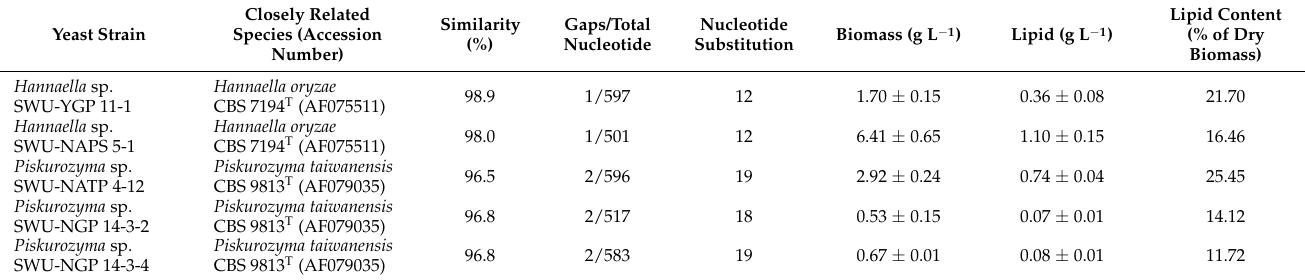
Table 3. Lipid accumulation of five strains of the potential new yeast